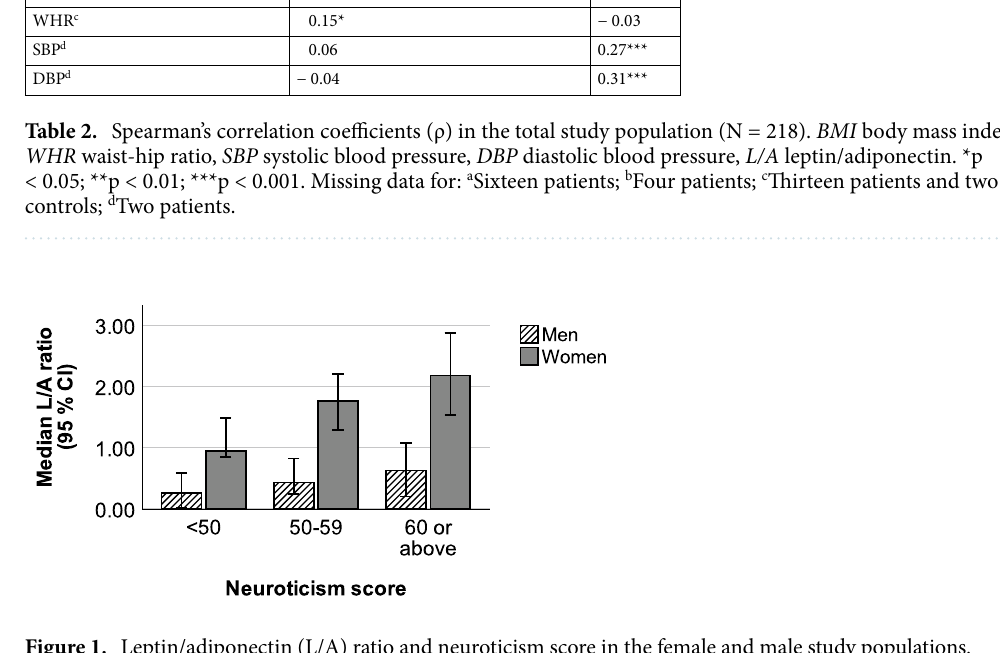
Figure 1. Leptin/adiponectin (L/A) ratio and neuroticism score in the female and male study